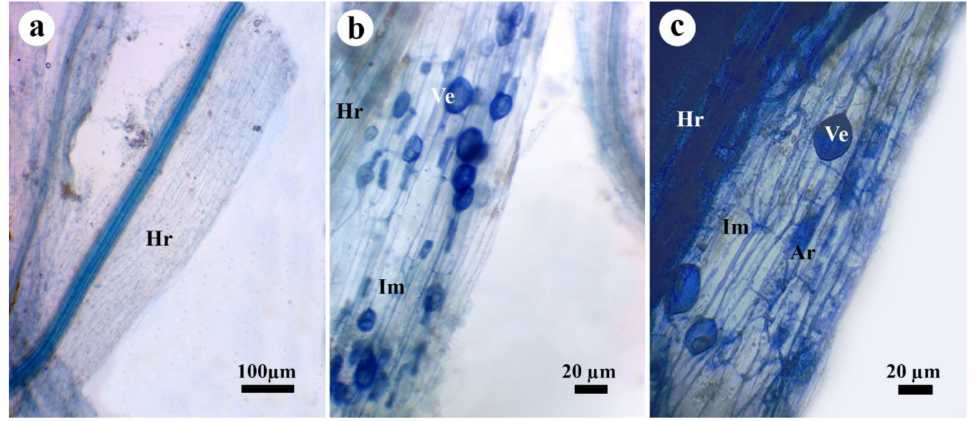
Figure 3. Pea root showing typical mycorrhizal structures. Where, ( a ) nonmycorrhizal root, ( b ) and ( c ) mycorrhizal roots, Hr = host root, Im = interaradical mycelia, Ve = vesicle, and Ar =